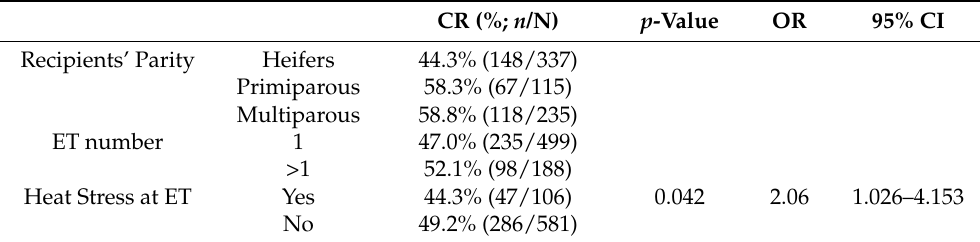
Table 2. Conception rate after embryo transfer (ET) of Japanese Black bovine embryos by recipients’ parity, transfer number, and heat stress at